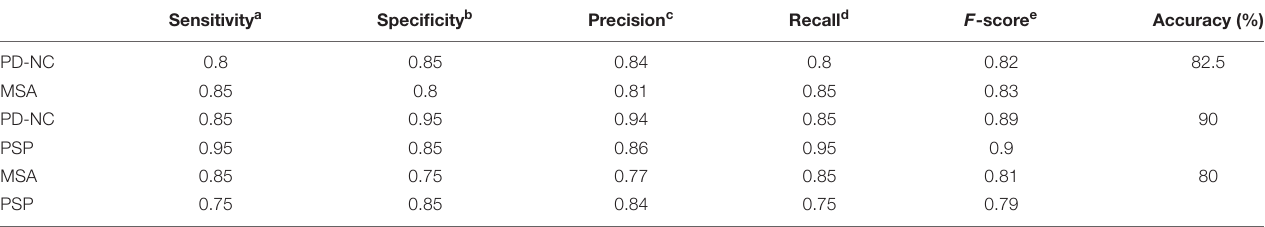
Sensitivity a Specificity